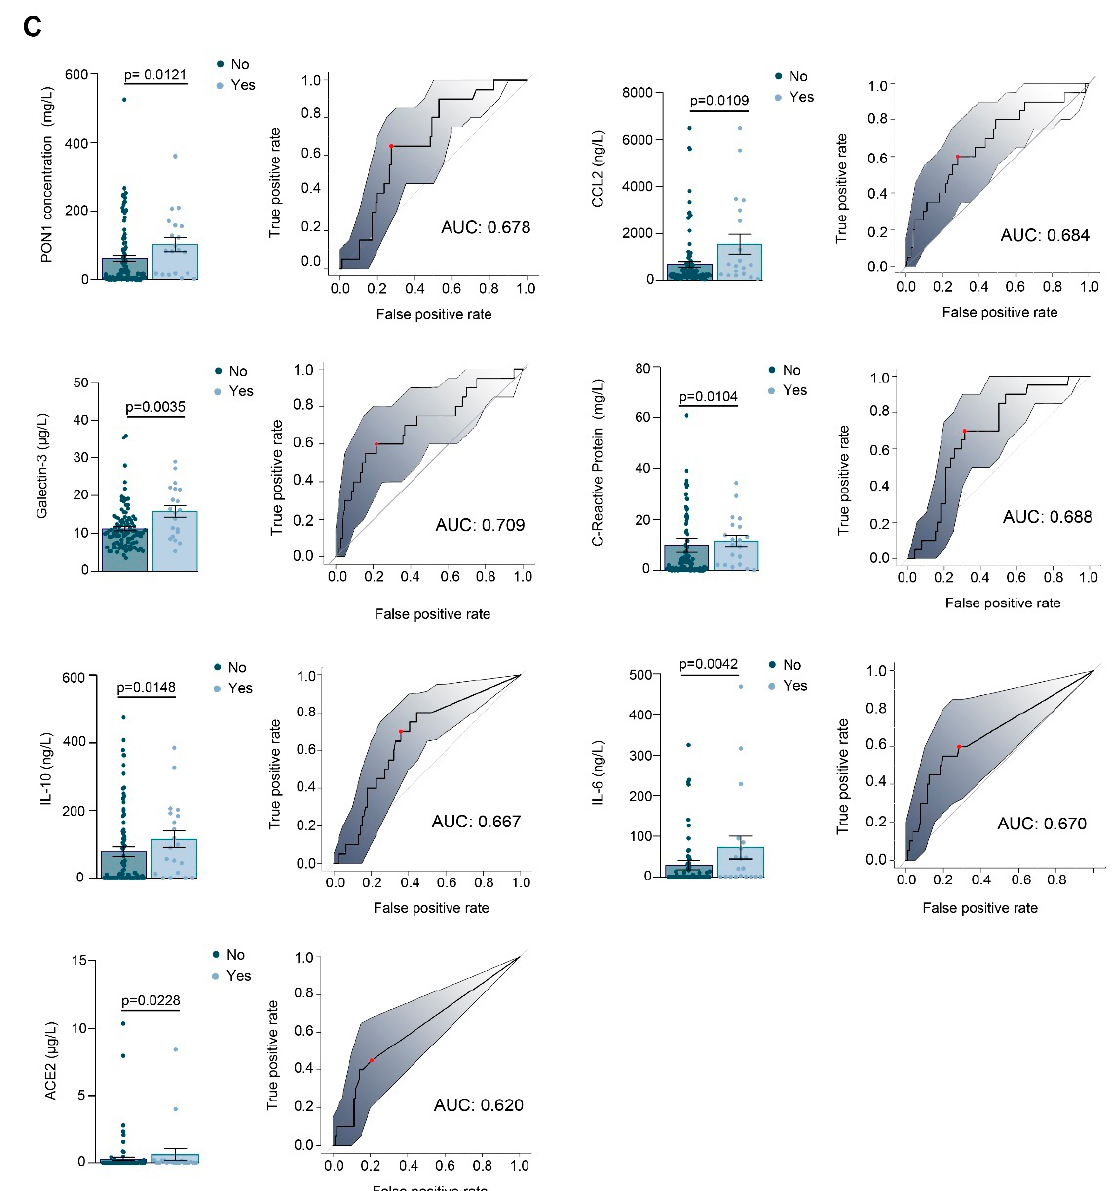
Figure 4. Relationships between selected variables and the clinical characteristics of COVID-19 positive patients. The figure shows scatter plots with error bars and Receiver Operating Characteristics curves of the variables that presented with significant differences in relation to whether patients were admitted to Intensive Care Unit ( A ), died during their hospital stay ( B ), or received invasive mechanical ventilation ( C ). Results are given as means and standard error of the mean (SEM). Statistical analyses were performed using the Mann-Whitney U test.